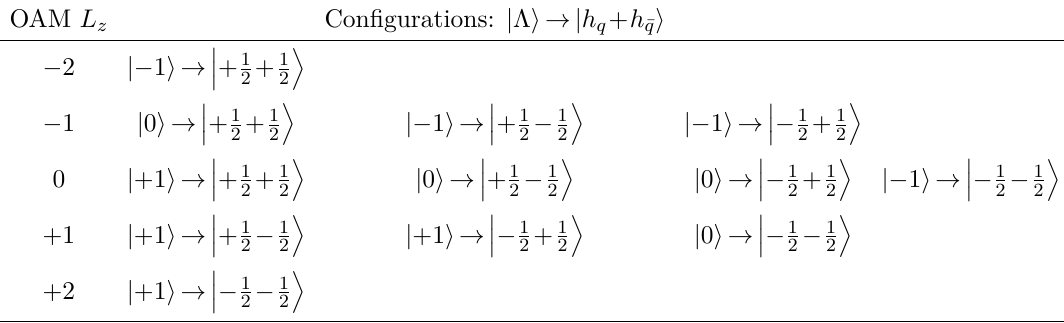
Table 1 . The possible orbital angular momentum L z contributions for ρ -meson light-front wave functions based on the different configurations of spin projections of valence quarks h q ,h ¯ q and hadron spin Λ